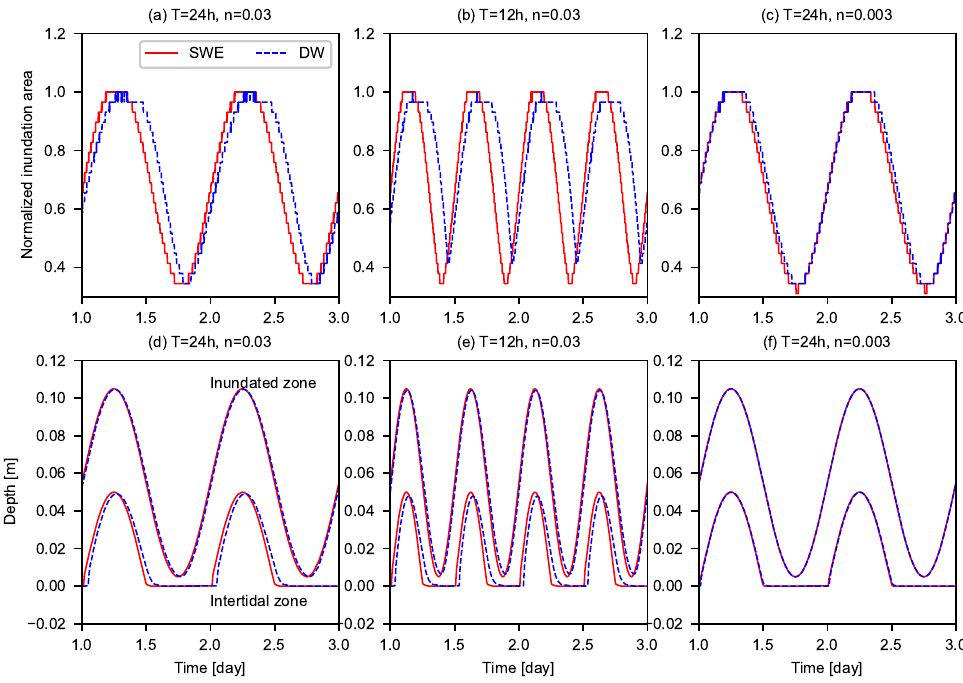
Figure 7. Surface water results for inundation of an intertidal zone: ( a – c ) evolution of normalized inundation area, ( d – f ) evolution of surface depth at 1/2 and 3/4 of the domain length, which corresponds to the intertidal zone and the fully inundated zone from Figure 6.